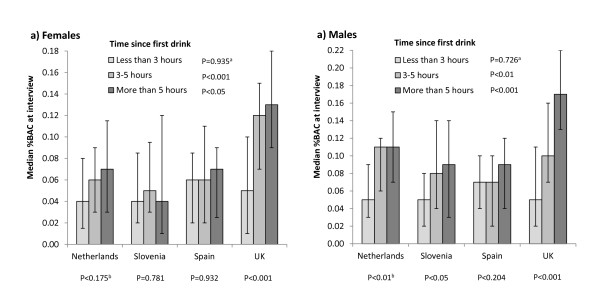
Median %BAC (and interquartile range) measured at interview by time since first drink. Analysis uses Kruskal Wallis Test. aP between nationalities across time periods; bP between time periods.